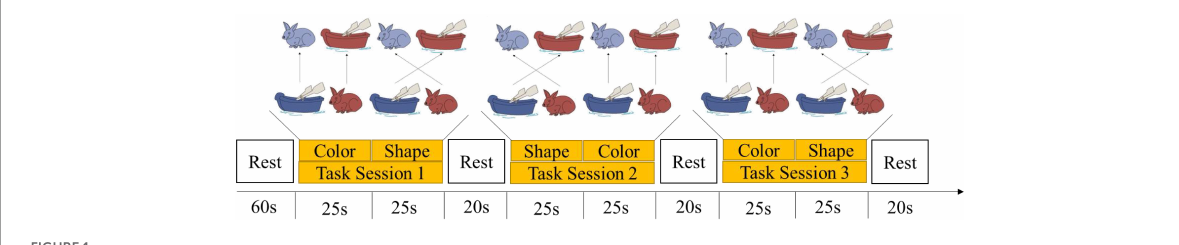
FIGURE1 Experiment paradigm of the DCCS task.